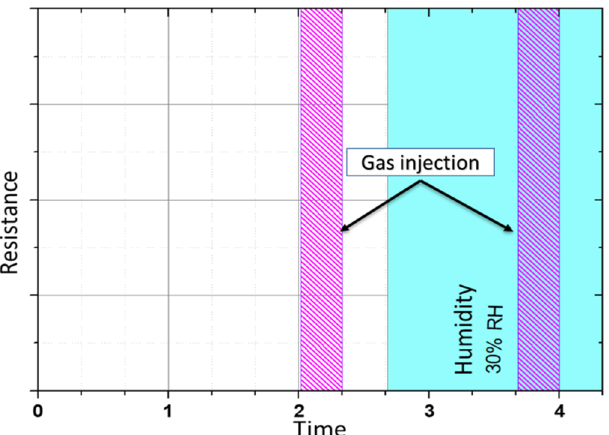
Figure 11. Static test protocol: equivalent resistance measurement versus time under various atmospheres.